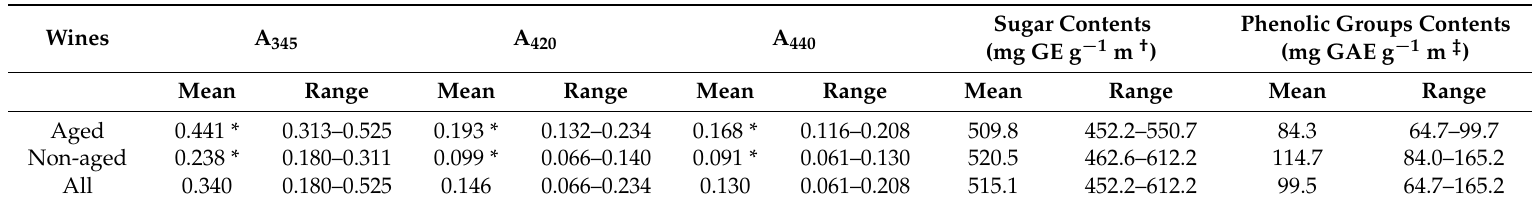
Chemical properties (A 345 , A 420 , A 440 , sugar, and phenolic contents) of melanoidins isolated from aged and non-aged Commandaria wines. Significant differences ( p < 0.05) for aged and non-aged Commandaria wines are denoted with